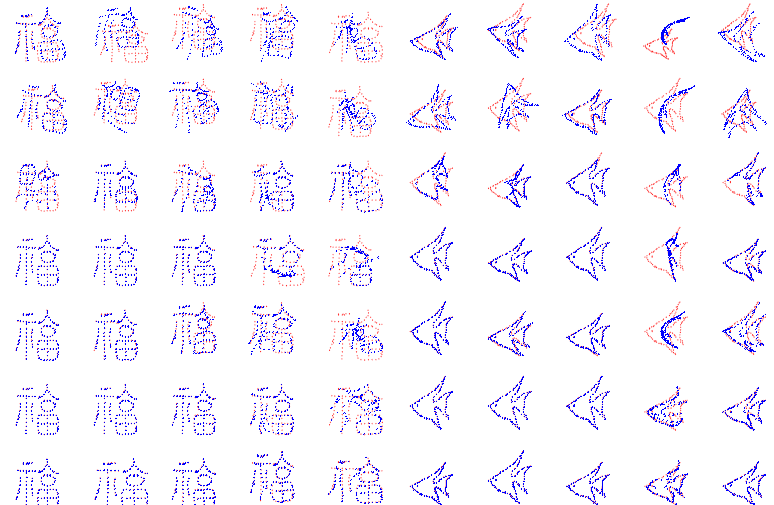
Figure 7. Registration results obtained from the application of pair-wise rivals on the Chinese characters set and fish shapes for different level of degradation. Data with different levels of deformation (first row) and the corresponding obtained results by KC (second row), ICP (third row), TPS-RPM (fourth row), CPD (fifth row), CPD-GL (sixth row), and SCGF (seventh row).